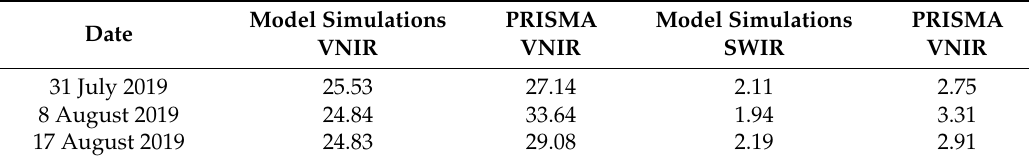
Table 3. Mean TOA radiance values from PRISMA and model simulations.